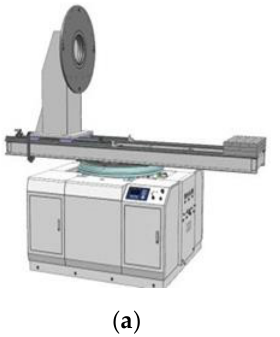
Figure 7. ( a ) Multi-station switching device and supporting tool — L-shaped bracket; ( b ) multi-station switching device and supporting tool — U-shaped bracket; ( c ) multi-station switching device and supporting tool — switching ring.